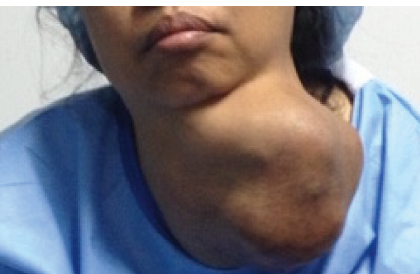
Figure 3: Recurrence of papillary carcinoma of the thyroid gland a year after